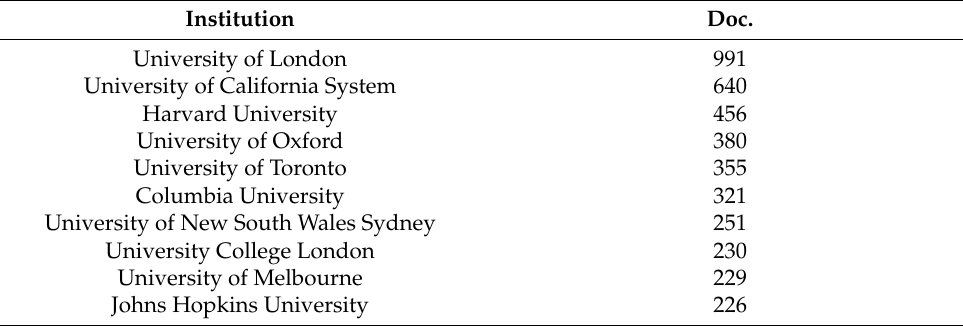
Table 3. Institutions that publish studies on the topic of human rights.